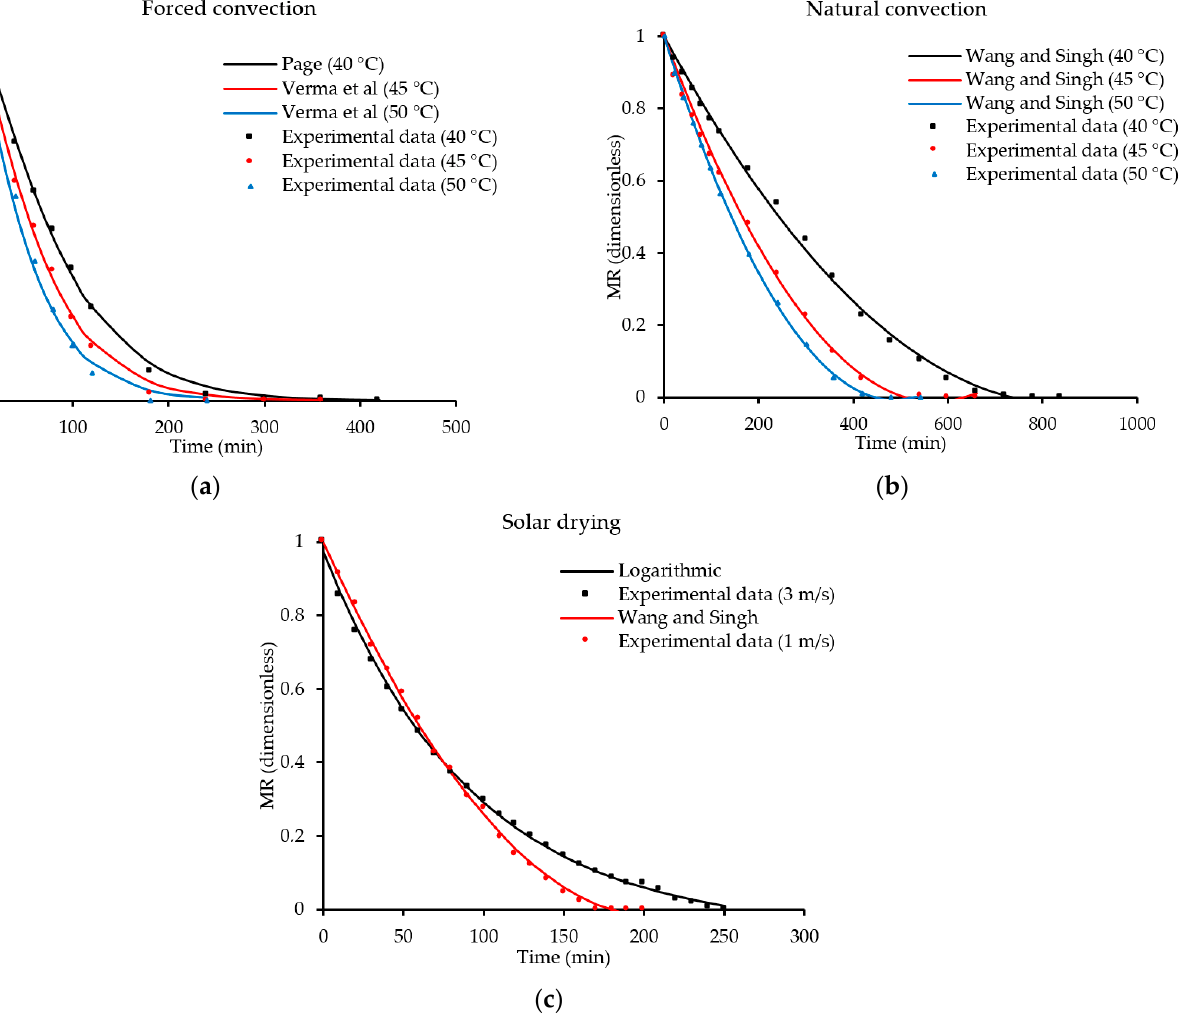
Figure 3. Mathematical fit of experimental drying data at different temperatures in ( a ) forced convection, ( b ) natural convection, and ( c ) solar drying [24,25].